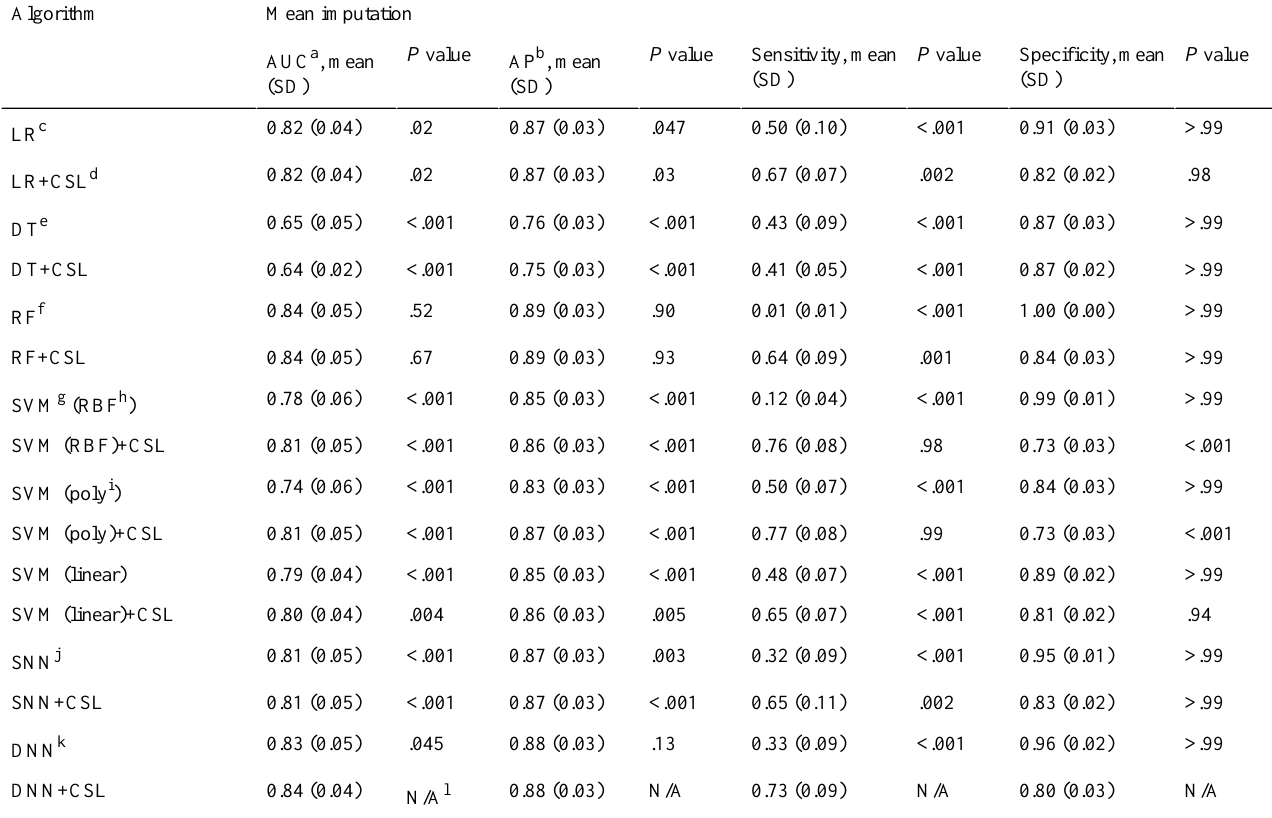
Table 2. Performance of algorithms with missing data handled by mean